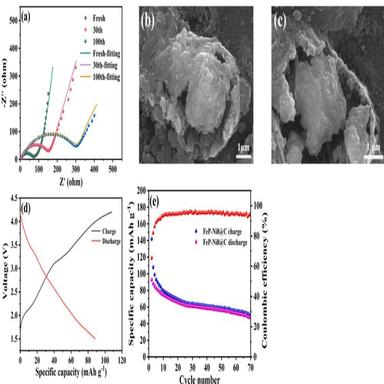
Various Nyquist plots at different cycle conditions for Ni-FeP@C (at a current density of 0.1 A g− 1 ) (a); FESEM images of Ni-FeP@C electrode after 100 cycles at 0.1 A g− 1 (b and c); Discharge/charge profiles at 100 mA g− 1 (d); and cycling performance of the full Li-ion battery (e).